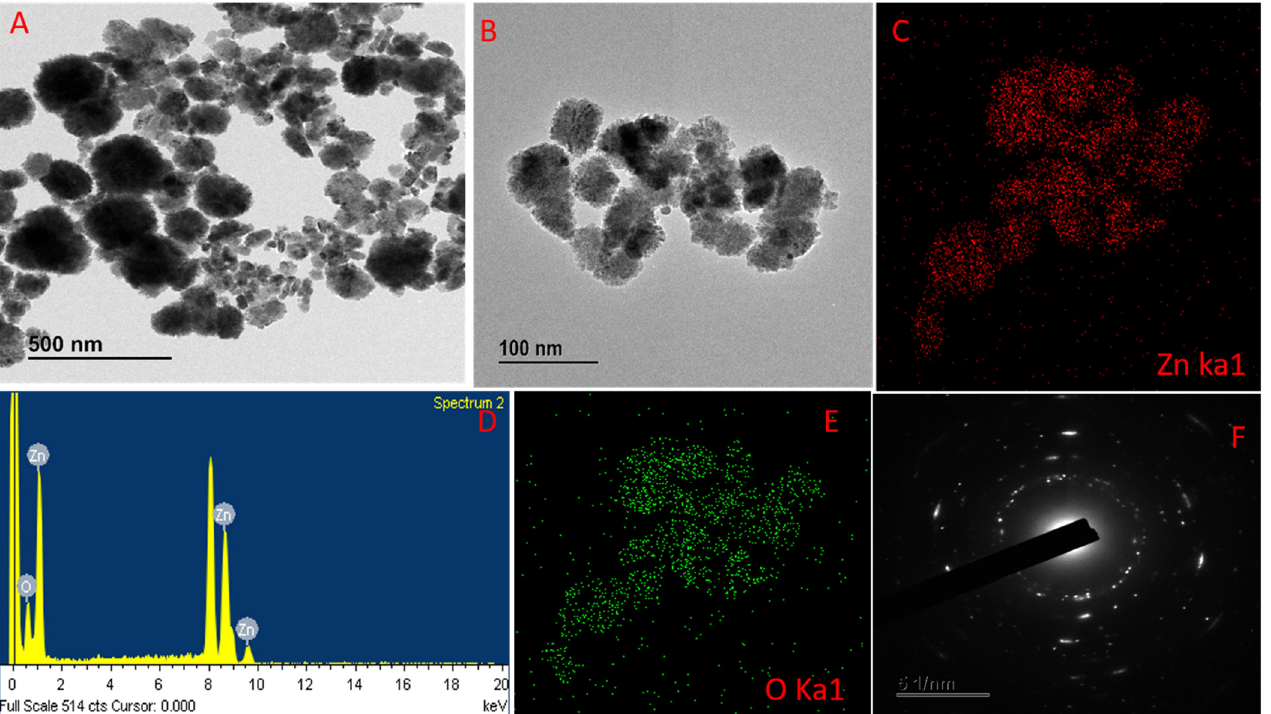
Figure 3. ( A , B ) FE-TEM images of GL–CMC–ZnO NCs. ( C ) Zinc elemental distribution of GL–CMC–ZnO NCs. ( D ) Energy dispersive X-ray spectroscopy (EDX) spectra of GL–CMC–ZnO NCs. ( E ) Oxygen elemental distribution of GL–CMC–ZnO NCs. ( F ) SAED structure of GL–CMC–ZnO NCs. Table 1. The percentages of zinc and oxygen in the GL–CMC–ZnO NCs through EDX analysis. Element Weight (%)